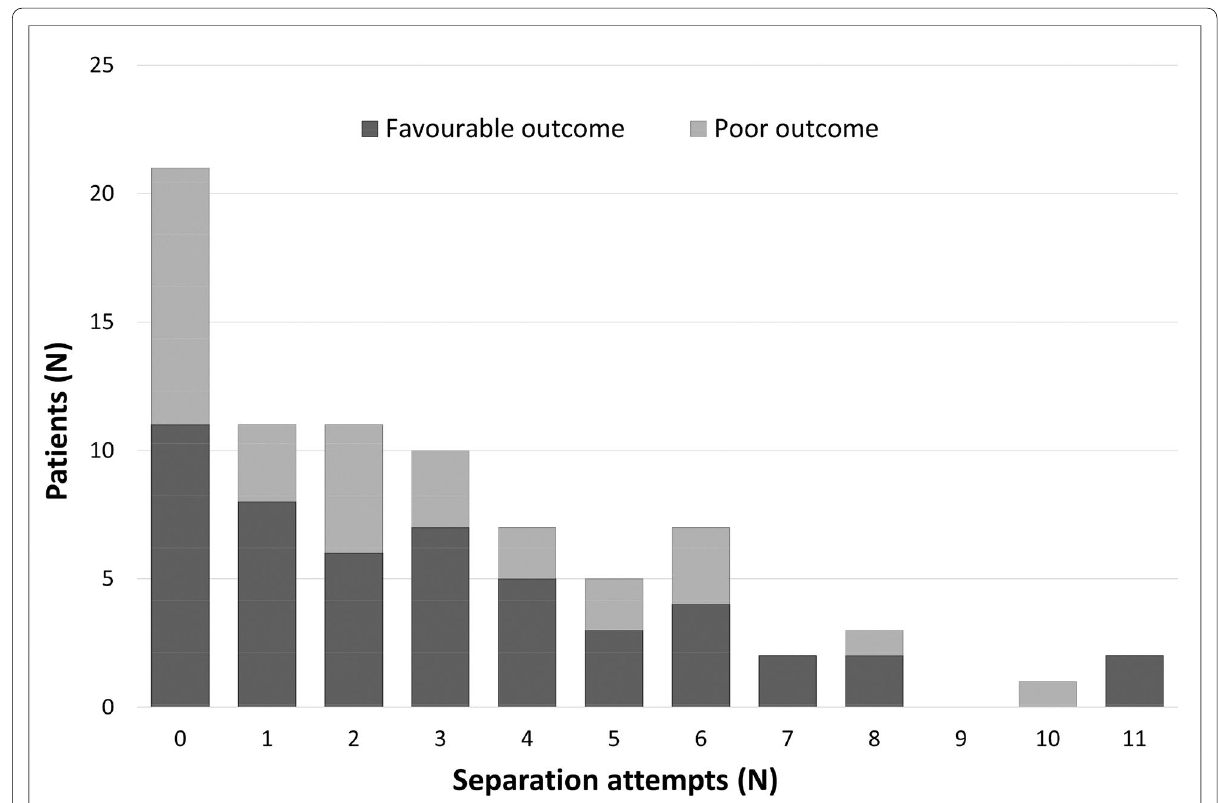
Fig. 2 Separation attempts before tracheostomy. Number of separation attempts by patients for each group of